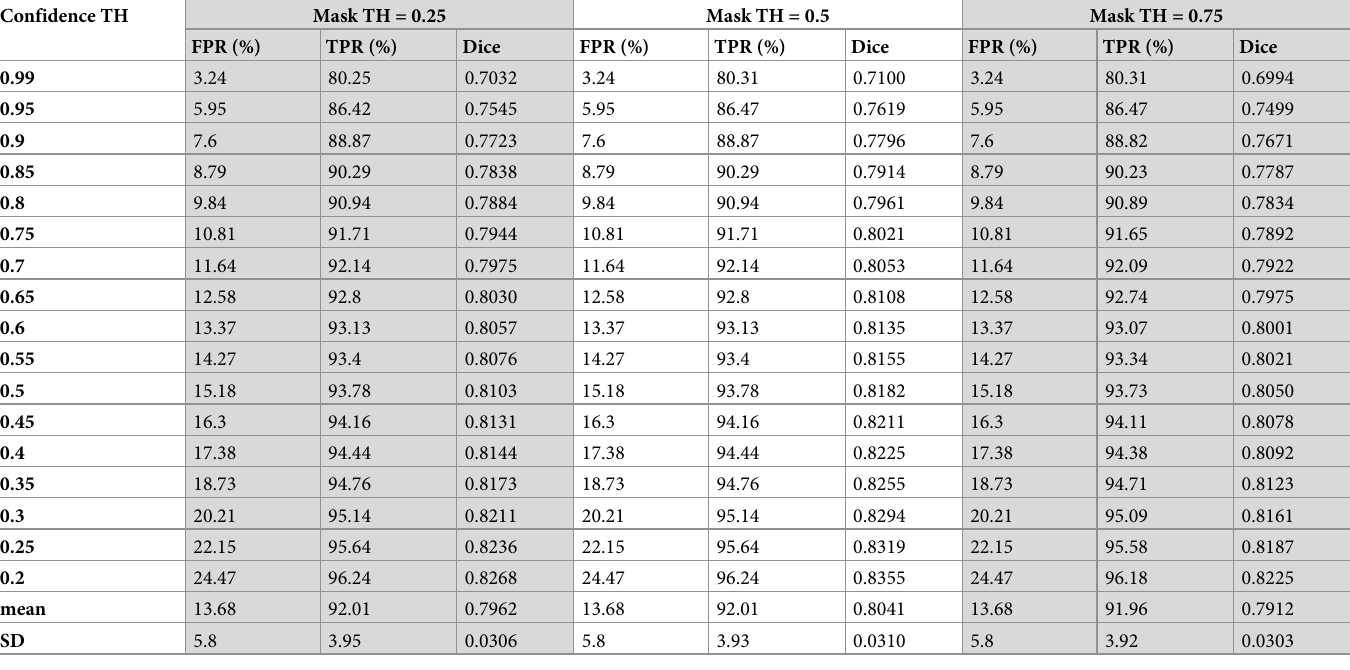
Table 2. TPR (%), FPR (%), and dice coefficients of different confidence THs and mask THs. Confidence